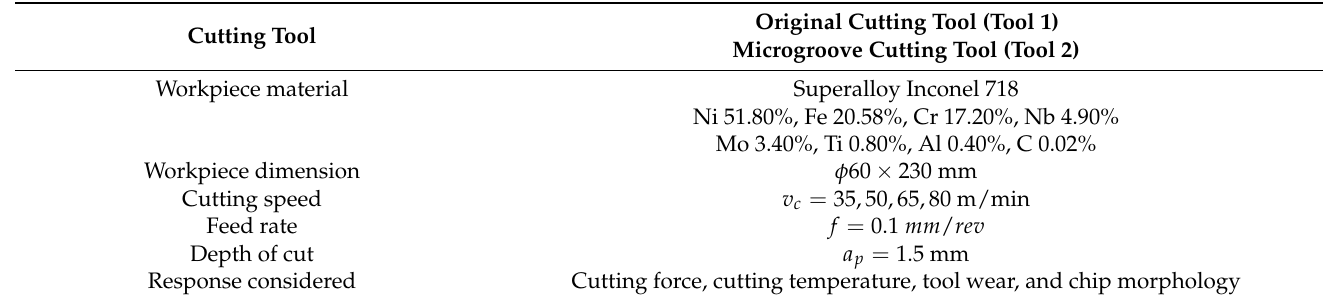
Table 1. Input process parameters of turning superalloy Inconel 718.